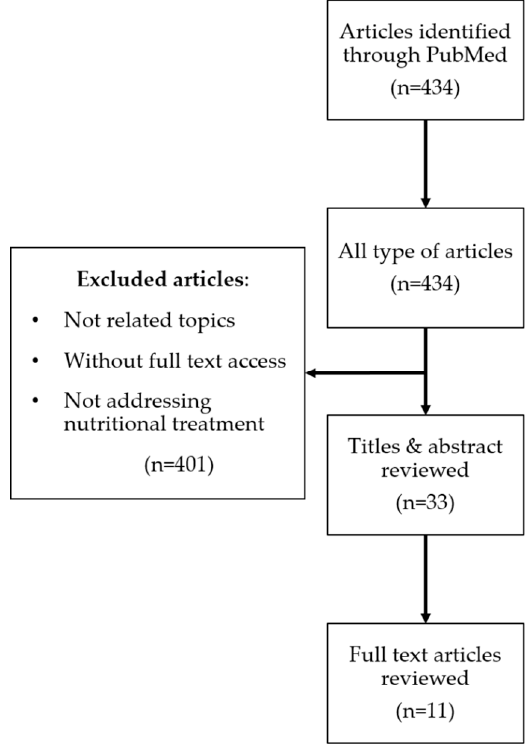
Figure A2. Searching flow chart for MCS.